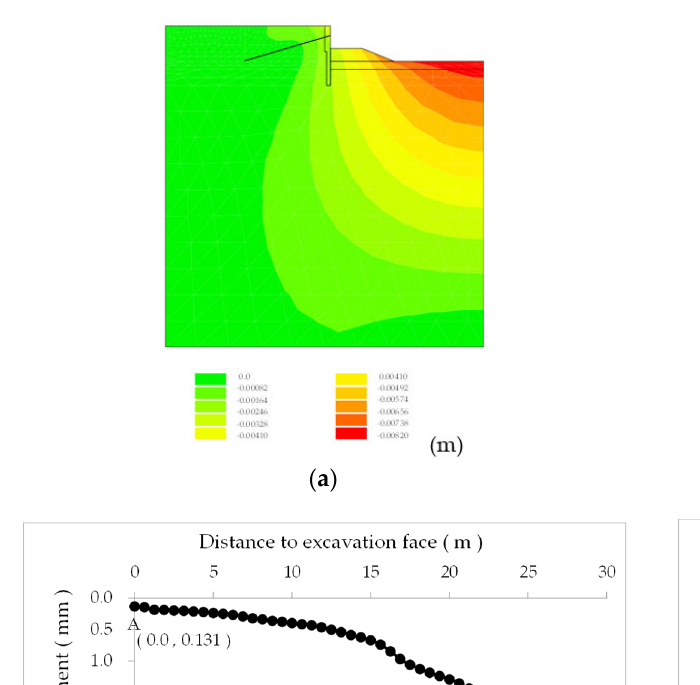
Figure 8a shows the iso ‐ value of the total displacement after the calculation of the